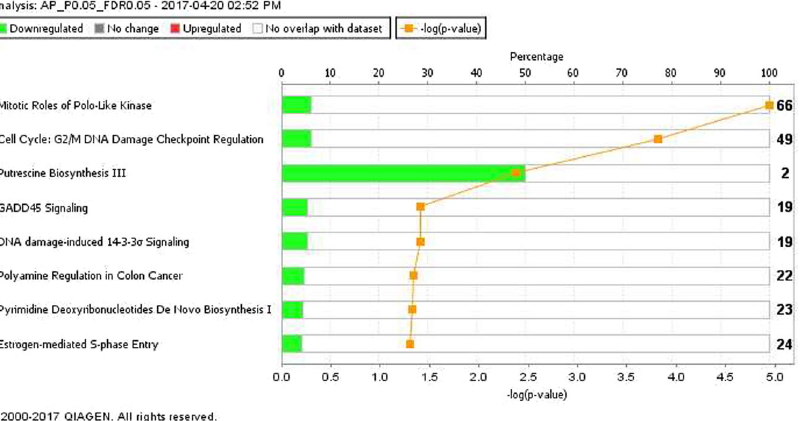
Figure 2. Biochemical pathways statistically significantly enriched in the anterior pituitary of Holstein-Friesian bull calves offered either a low or a high plane of nutrition and, slaughtered at 18 weeks of age. Green and red bars represent genes down and up regulated, respectively, as a percentage of the overall number of genes in each pathway. The significance of each pathway is represented by the yellow line describing − log(p-value). The P-value was calculated by the number of genes from our dataset of differentially expressed genes represented in a particular pathway, divided by the total number of genes in the Canonical Pathway in IPA analysis. Data were analyzed through the use of IPA (QIAGEN Inc., https://www.qiagenbioinformatics.com/products/ ingenuitypathway-analysis) 51